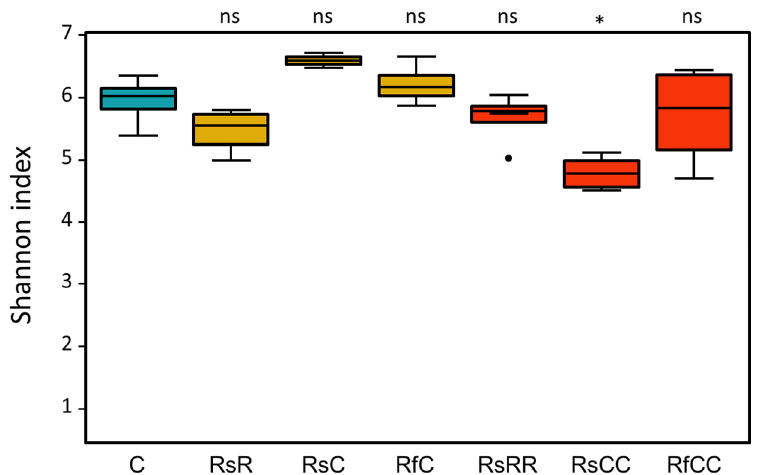
Figure 6. Alpha diversity (Shannon index) of the B. germanica gut microbiome of all experimental groups. The values of the t-test are shown above the bars (ns, p > 0.05; *, p <= 0.05). Blue box, control; yellow boxes, G2; red boxes, G3.